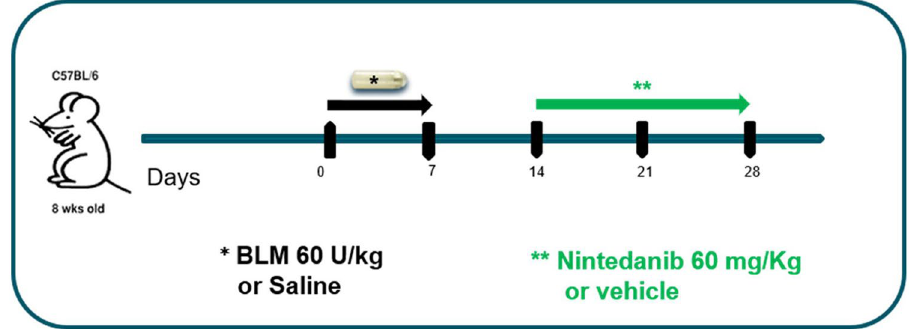
Figure 1. Experimental set up. Experimental timeline of bleomycin-induced lung mouse fibrosis by osmotic minipumps. Twenty-four females C57BL/6 were randomly assigned to receive either saline (8 mice) or BLM (60U/kg) by osmotic minipumps at day 0. From day 14, 8 animals from BLM group received nintedanib and the others 8 received vehicle until day 28. At the endpoint, the effect of nintedanib was assessed by micro-CT and ex-vivo